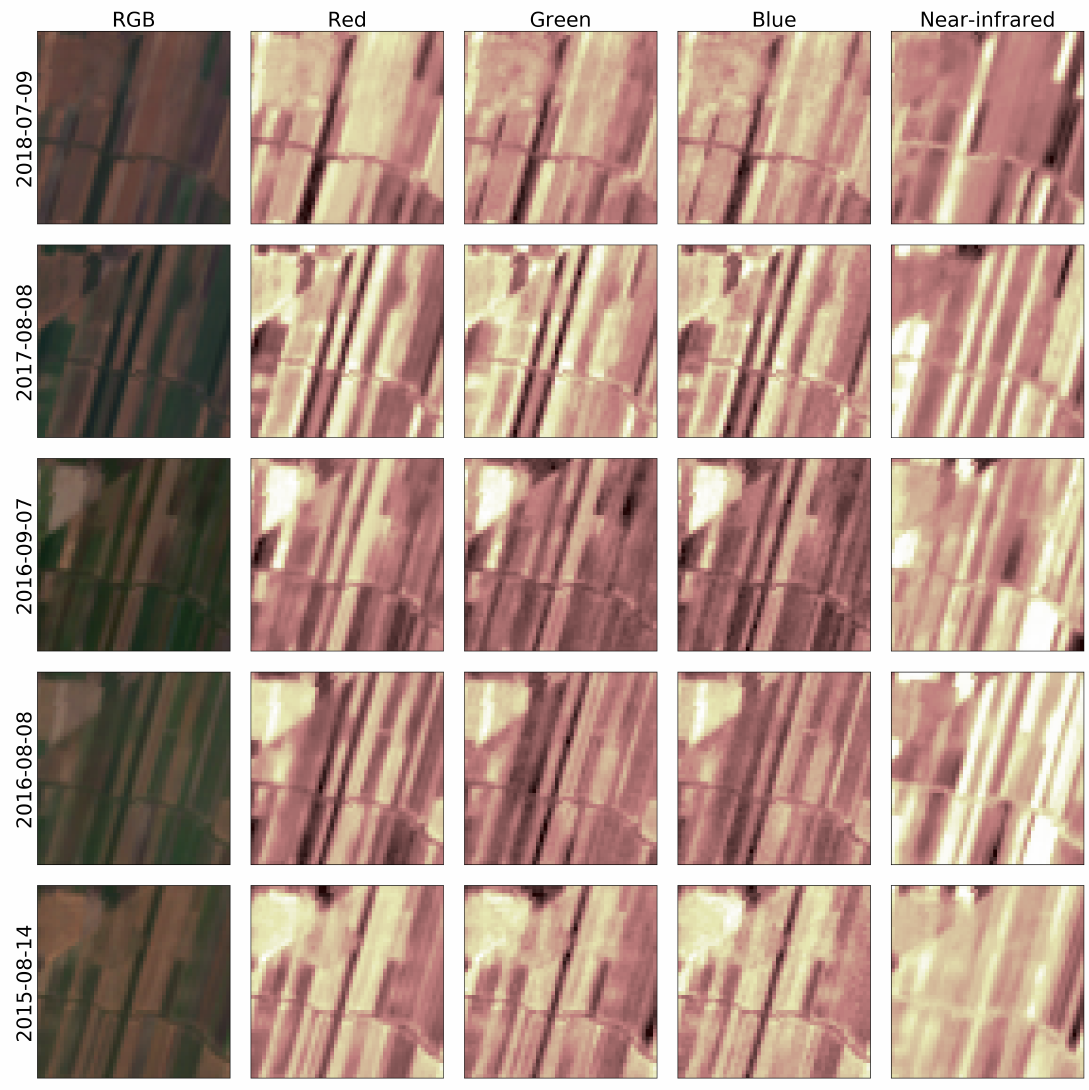
Figure 4. Time series of a single grid element classified as null-grade abandoned land. Original data class 0. The data sample is presented in RGB and near-infrared